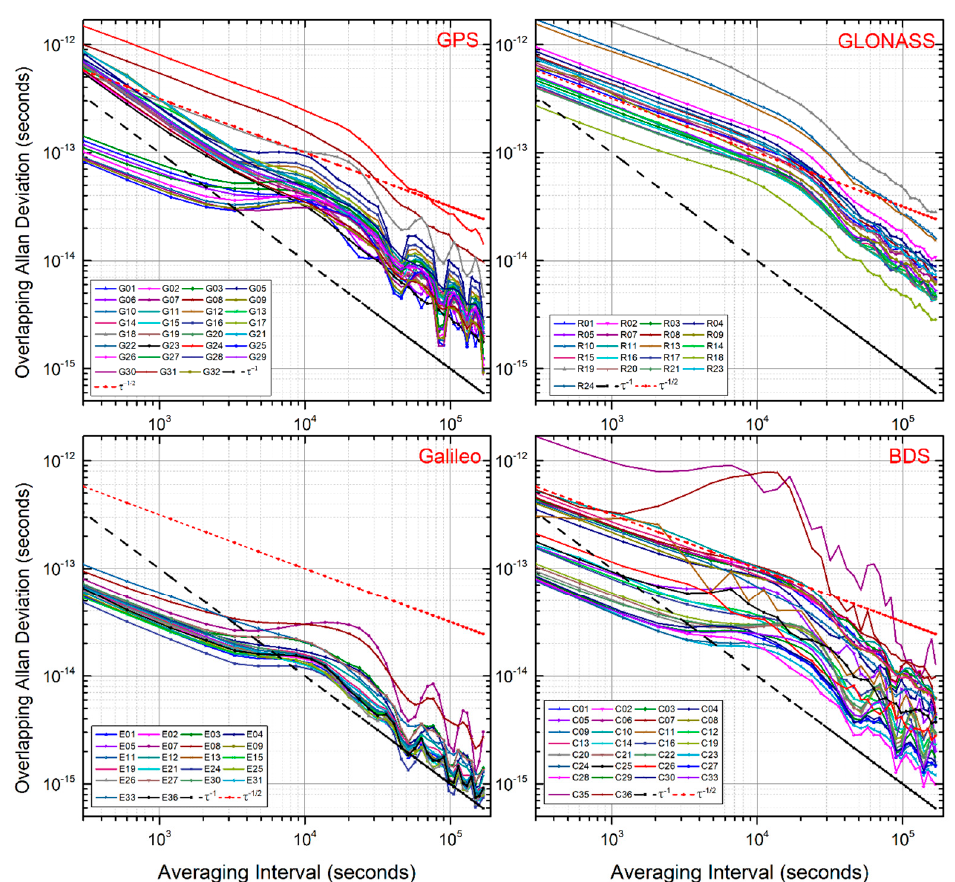
Figure 10. The GPS/GLONASS/Galileo/BDS satellites frequency stability calculated by overlapping Figure 10. The GPS / GLONASS / Galileo / BDS satellites frequency stability calculated by overlapping Allan Deviation. Allan Deviation. Table 9. The frequency stability of the BD3 satellites at intervals of 10,000 s and 86,400